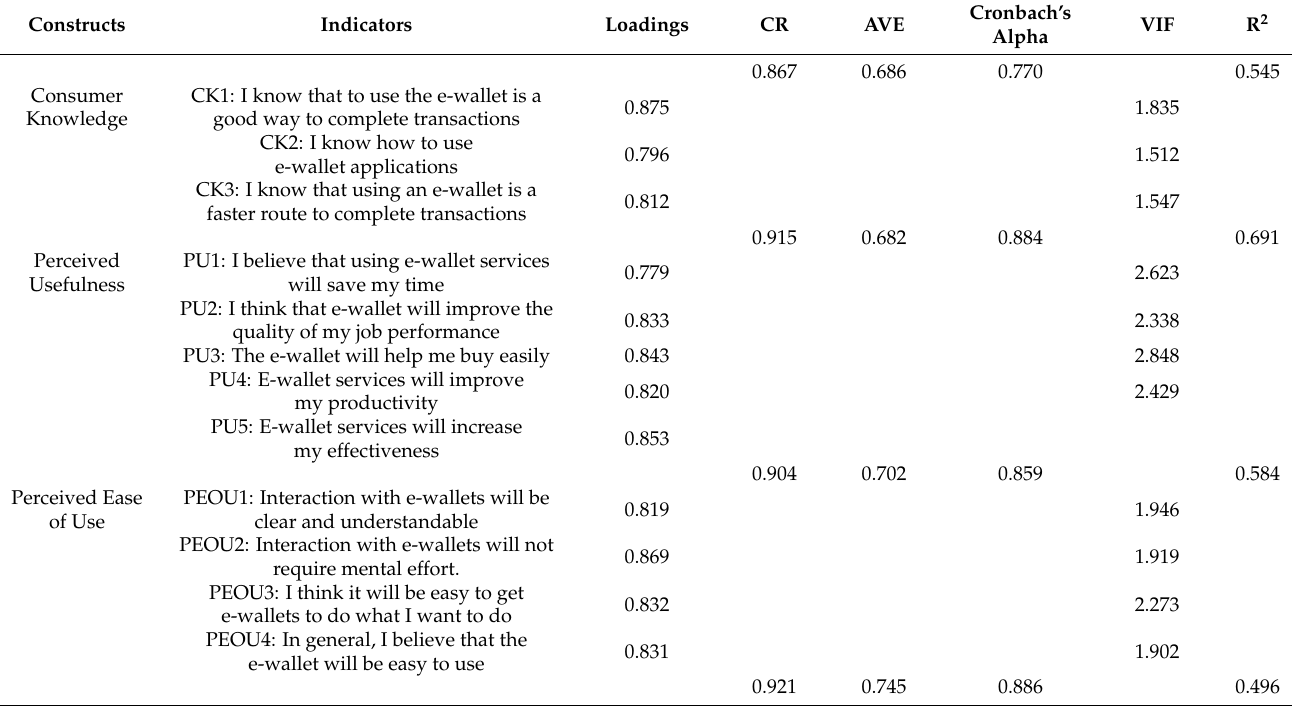
Table 3. Item loadings, CR, AVE, Cronbach’s alpha, variance inflation figures (VIF) and R-square